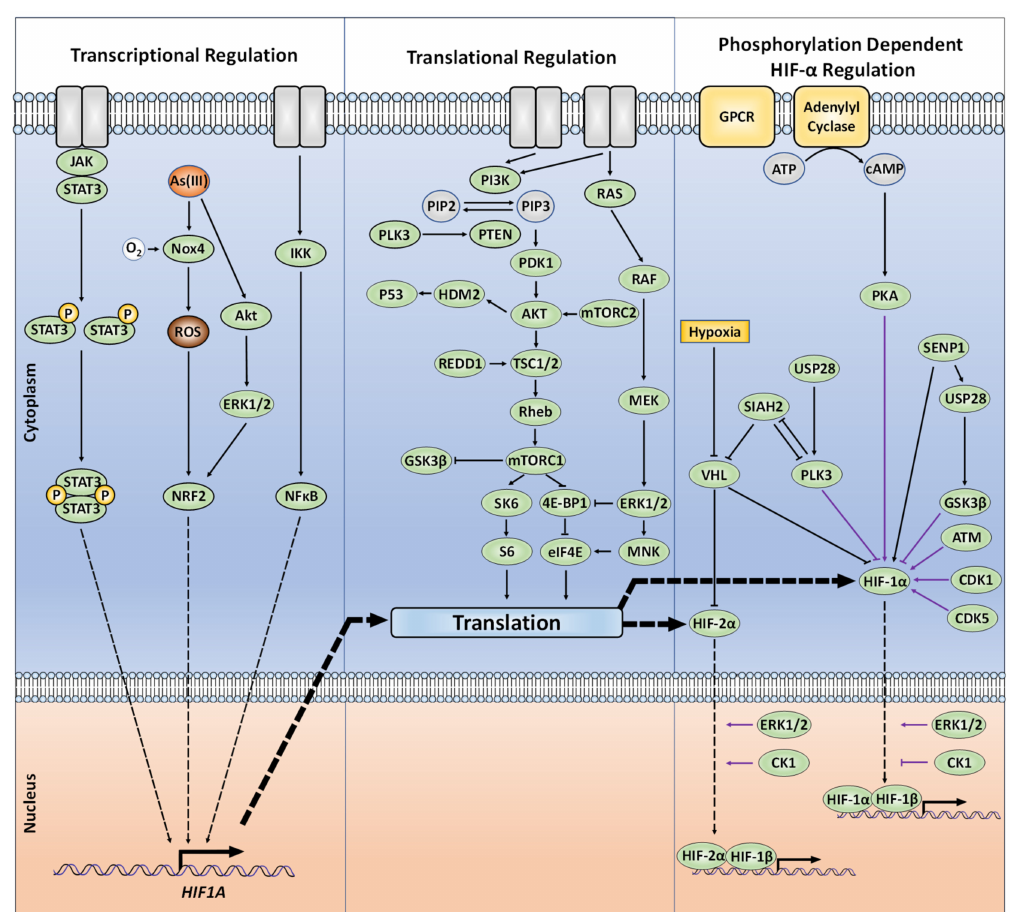
Figure 3. The intracellular protein-dependent cell signalling for the transcriptional, translational, and phosphorylation- dependent regulation of HIF- α . Purple arrows indicate protein kinases that directly phosphorylate HIF- α